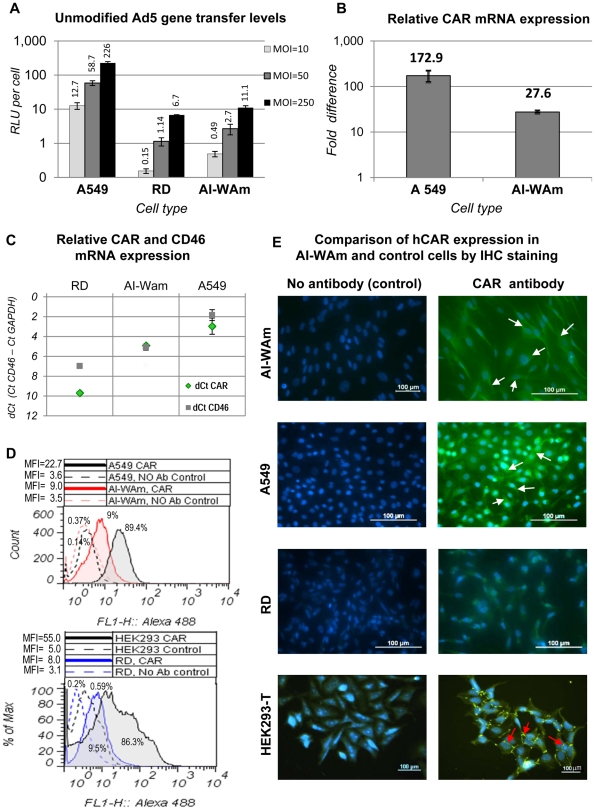
Ad5 gene transfer to AI-WAm cells is limited by deficiency in expression and/or cell surface localization of the Ad5 receptor CAR.
A. Gene transfer efficiency of a human Ad5 vector expressing Luc reporter (Ad5 (L)) to an AI patient-derived ameloblast-like cells (AI-WAm) at different multiplicities of infection (MOI) (MOI = 10, 50 and 250 TCID50/cell) in comparison to CAR-positive A549 and CAR-negative RD cells by conventional Luc assay at 20 hours post infection. Results are presented in Relative Luc Units (RLU) per cell with mean values shown above each bar plus/minus standard deviation. All differences were statistically significant (P<0.05) B. Expression levels of hCAR mRNA in AI-WAm and A549 cells relative to that in RD cells as determined by qRT-PCR and presented as “fold difference”. All differences were statistically significant (P<0.05). P(A549/AI-WAm) = 0.027. C. Quantitative analysis of hCAR and hCD46 mRNA expression levels in RD, AI-WAm and A549 cells as determined by qRT-PCR and normalized to the housekeeping gene GAPDH. The data are presented as ΔΔCt values. For AI-WAm P(CAR/CD46) = 0.44; for A549 P(CAR/CD46) = 0.127; for RD P(CAR/CD46) = 0.007; for CAR P(AI-WAm/A549) = 0.049; P(RD/AI-WAm) = 0.033; for CD46 P(RD/AI-WAm) = 0.0011; P(AI-WAm/A549) = 0.0008. P-values for all other differences were <0.05. D. Flow cytometry analysis of Ad5 receptor (CAR) expression in AI-WAm cell population in comparison with CAR-positive (A549) and CAR-negative (RD) control cells. Cells were incubated with primary anti-CAR (RmcB) monoclonal antibody (Ab) followed by labeling with Alexa 488-conjugated secondary antibodies. No primary Ab was used in negative control samples. The extent of shift in the fluorescent peak positions (color lines) relative to control peak(s) of unlabeled cells (black dotted lines) reflects the extent of cell labeling, corresponding to the receptor expression on each cell type and is expressed as Mean Fluorescence Intensity (MFI). Numbers above each peak correspond to percentage (%) of gated (M2) cells calculated using subjective gating. Fluorescence intensity (X-axis) is plotted as histograms on log scale (X-axis) using Flowjo 7.6.4 software (Tree Star Inc., Ashland OR). Y-axis depicts total events (cells) and expressed either as counts or % of maximal. P(AI-WAm/A549) = 0.0038; P(AI-WAm/RD) = 0.39; P(A549/RD) = 0.0018; P(A549/HEK293T) = 0.018; CAR P(AI-WAm/HEK293) = 0.0001; P(HEK293/RD) = 0.001; E. Comparison of hCAR expression in AI-WAm and control cells by IHC staining. CAR-specific (RmcB) primary antibody (same as used for FACS analysis, D) was used to stain AI-WAm cells. A549 and HEK293-T cells were used as positive and RD cells as negative controls for CAR expression. All cells were counter-stained for 5 min. with 300 nM DAPI to visualize nuclear DNA (blue). No primary antibody was used with control samples. Negative control (RD) cells show efficient nuclear staining but no discernible CAR staining (green), while A549 cells demonstrate a strong CAR-specific signal and AI-WAm cells display a moderate level of hCAR signal with diffuse pattern of cytosolic localization (white arrows) similar to that in A549 cells. In sharp contrast, CAR-overexpressing HEK293-T cells show a distinct localization of CAR protein in the cell membrane tight junctions (red arrows) with lesser cytosolic staining. Scale bars correspond to 100 µm.